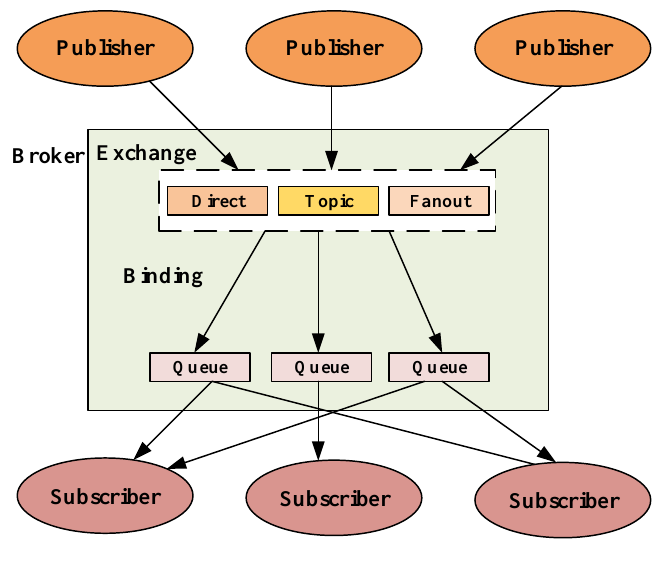
Figure 4. AMQP architecture.